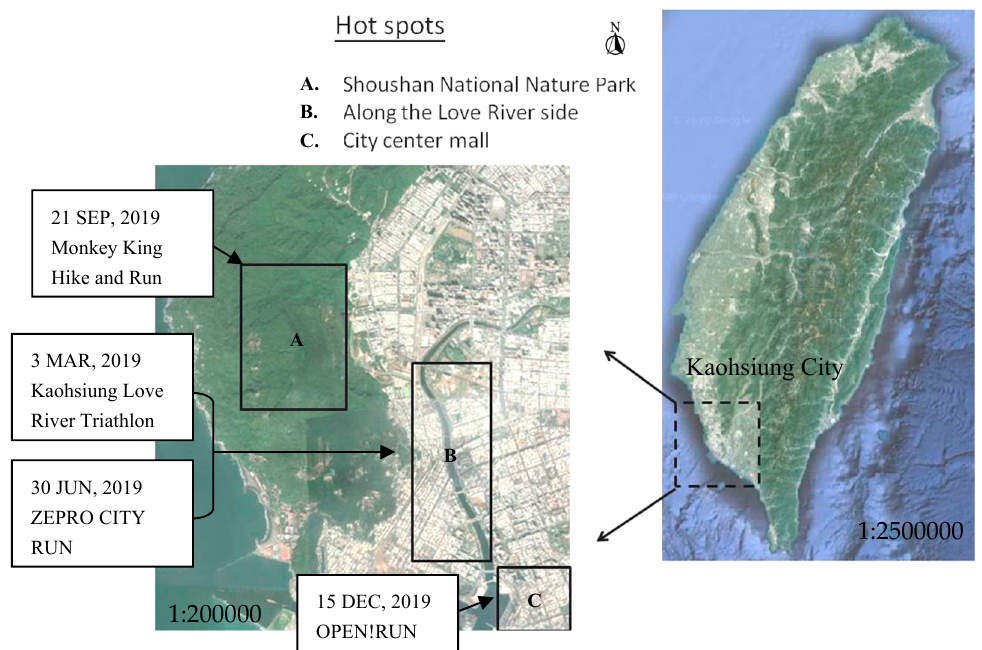
Figure 2. Focus areas and running events selections.